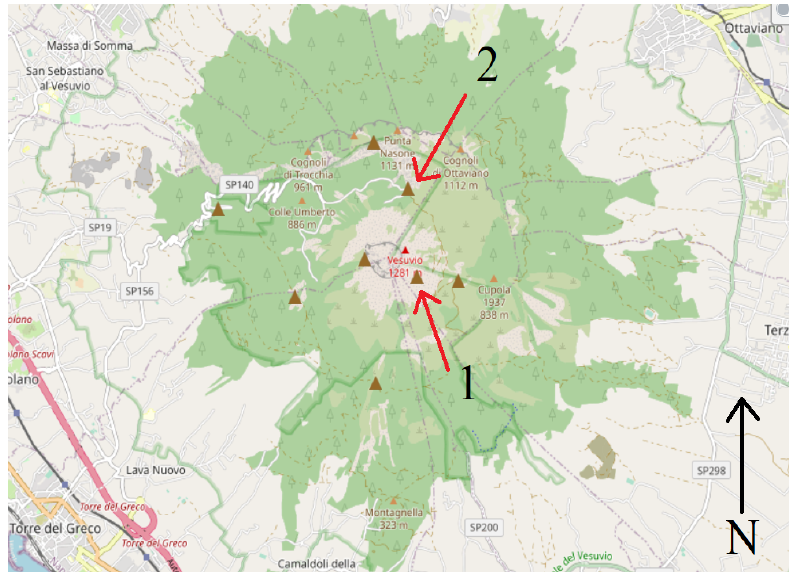
Figure 17. “In situ” seismograph stations.